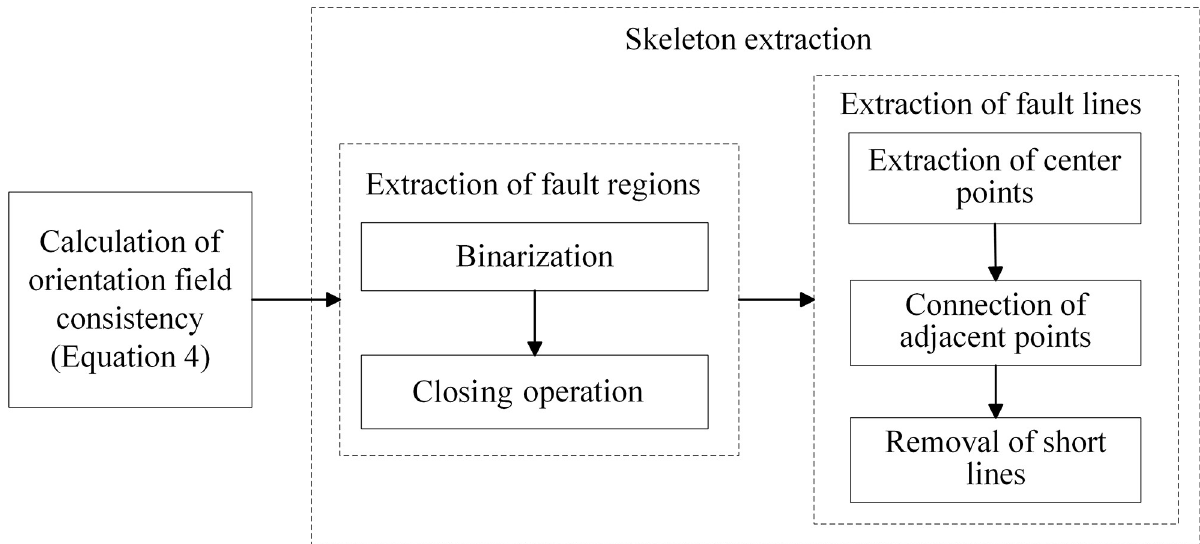
Fig 2. Flowchart of fault